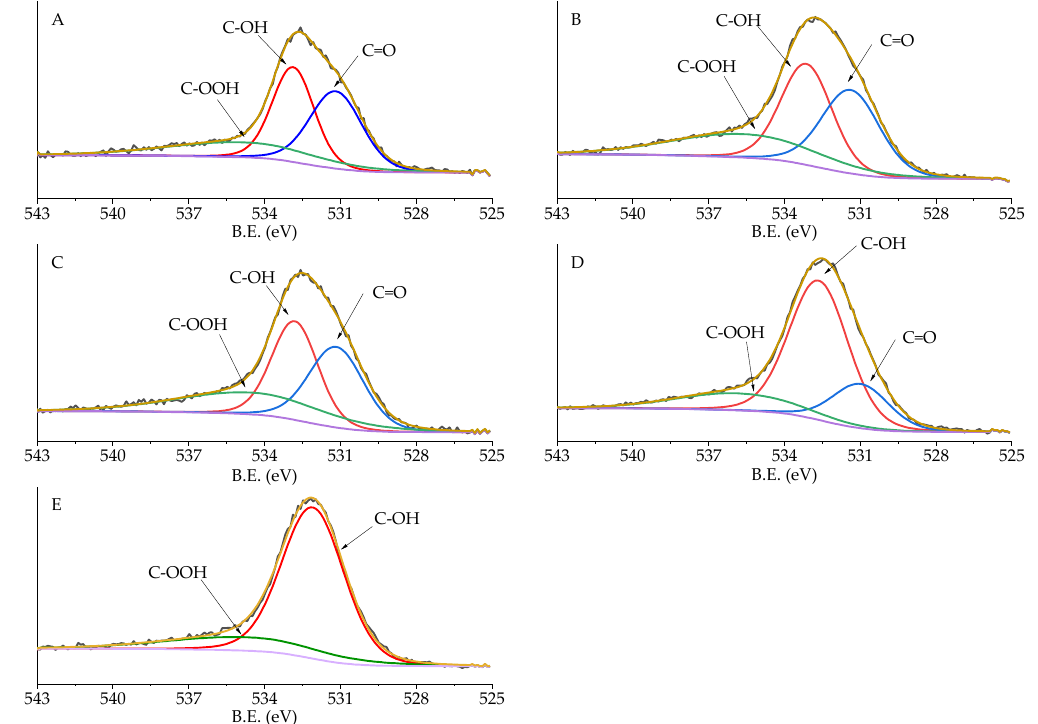
Figure 5. XPS spectra of O 1s region of ( A ) Pd / KB_0.0, ( B ) Pd / KB_0.1, ( C ) Pd / KB_0.3, ( D ) Pd / KB_0.65, and ( E ) Pd / KB_1.2 catalysts.